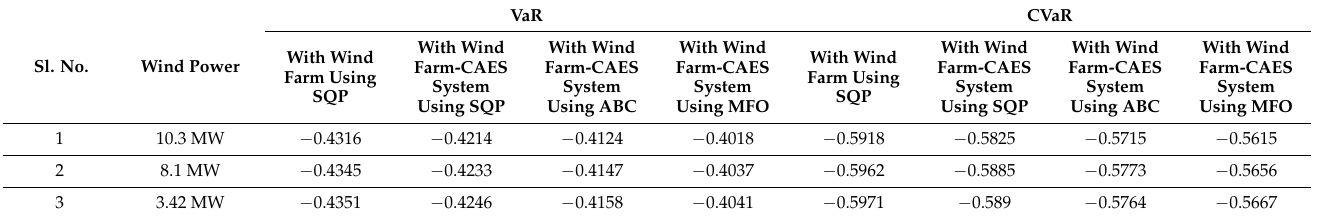
Table 10. System risk with various optimization methods for Delhi under various system